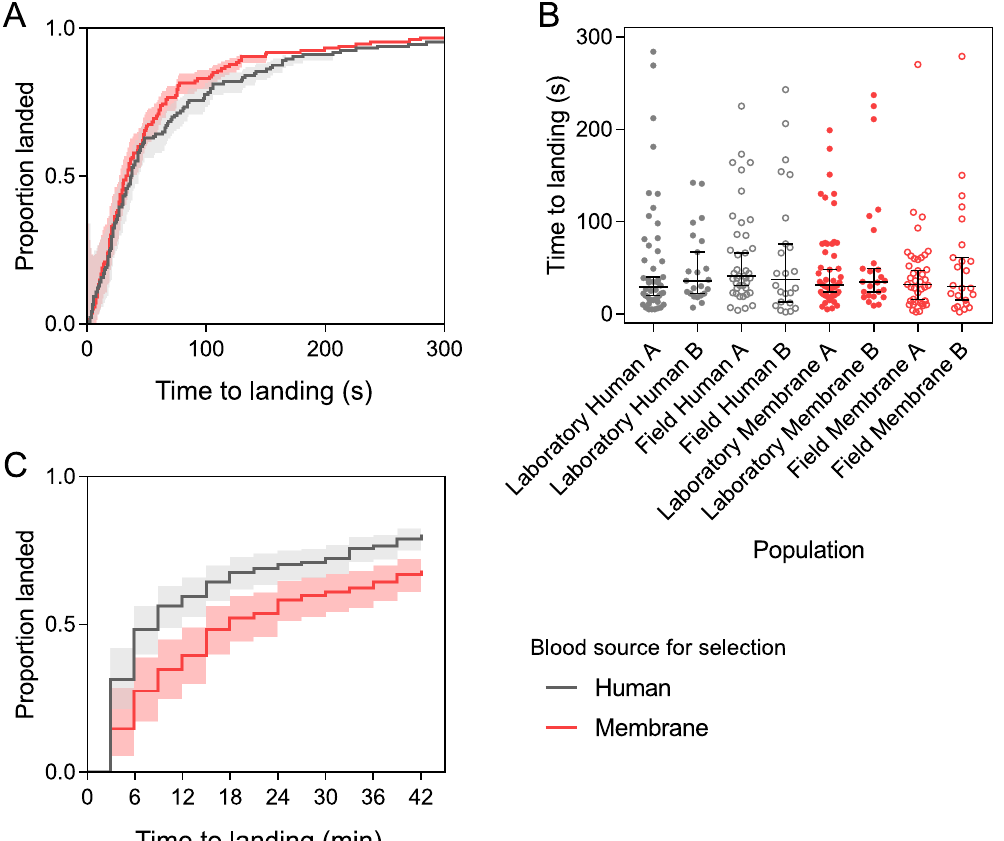
Fig 5. Host-seeking ability of human-selected and membrane-selected Aedes aegypti females in BugDorm cages in the laboratory (A-B) and in a semi-field cage (right). (A) and (C) show the cumulative proportion of human- and membrane-selected females landing over time, where shaded areas are 95% confidence intervals. Landing times for individual mosquitoes from each population tested in laboratory cages are shown in (B) with medians shown, where error bars are 95% confidence